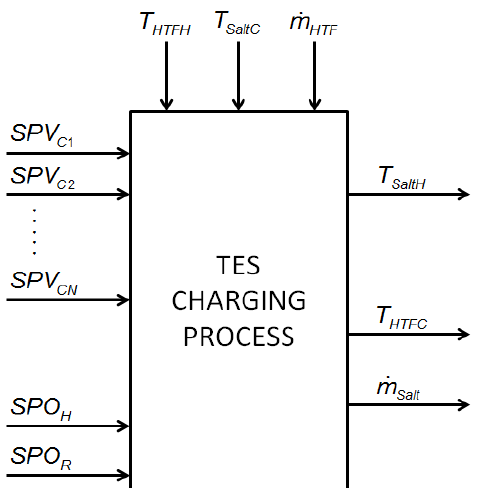
Figure 4. Process block associated to TES